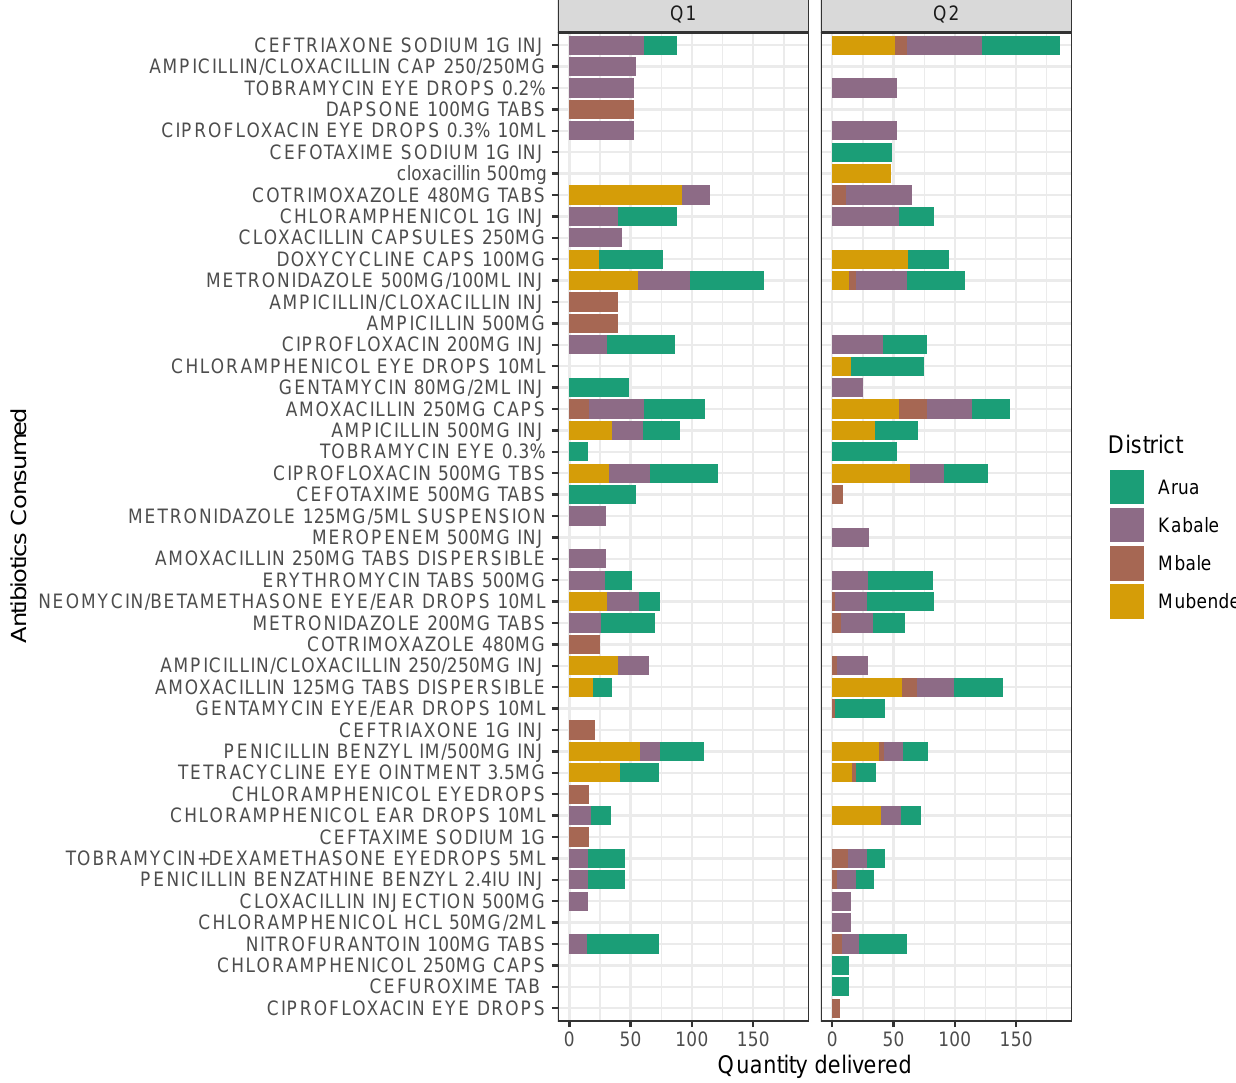
Figure 9. Antibiotic consumption performance among four Sentinel Sites, Data Collection by AMU/C Technical Working Group with support from IDI-GHSA